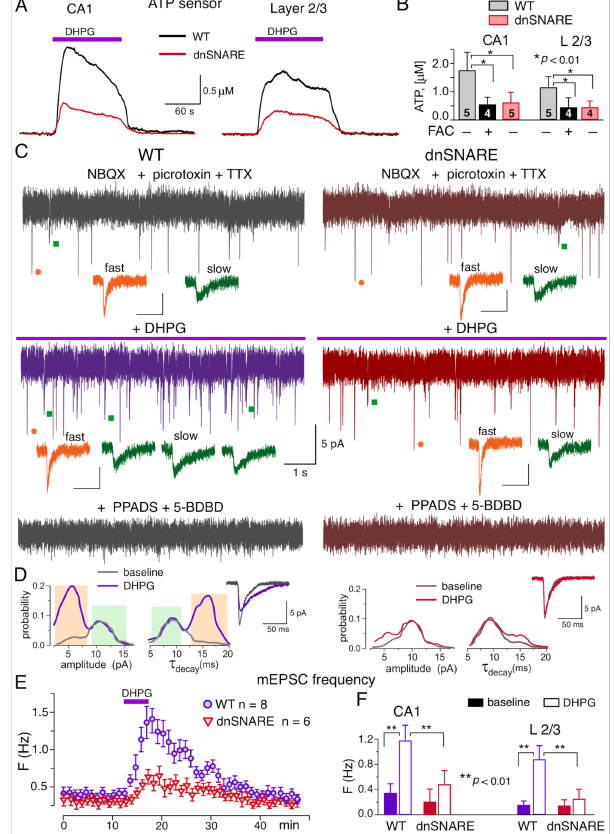
Figure 2. mGluR-activated release of ATP in hippocampal and neocortical slices. ( A , B ) Release of ATP assessed with microelectrode biosensors to ATP placed in the stratum radiatum of CA1 area and layer 3 of neocortex. ( A ) Representative ATP-responses to the application of DHPG. ( B ) The average peak amplitude of DHPG-elicited ATP-transients recorded in the CA1 and layer 2/3 of wild-type and dnSNARE mice (mean ± SD for number of slice indicated); asterisks (*) indicate the significance of difference according to t -test. Note the significant decrease in the DHPG-evoked responses in the dnSNARE mice and in the WT mice under FAC. ( C – F ) Spontaneous currents were recorded in the CA1 pyramidal neurons of WT (left) and dnSNARE (right) mice at − 80 mV under picrotoxin, NBQX and TTX. ( C ), the representative traces show, from top to bottom, the currents recorded in the baseline, 5 min after DHPG application, and in the presence of P2X receptor antagonists PPADS and 5-BDBD applied 30 min after DHPG. Note that purinergic antagonists fully eliminated the spontaneous currents. The inlays show the examples of purinergic events of fast (orange) and slow (green) kinetics recoded as indicated by the dots; the scale bar in inlays are 50 ms and 5 pA. ( D ) The amplitude and decay time ( τ decay ) distributions and average waveforms (mean of 20 consecutive events) of the purinergic currents recoded before (baseline) and within 5 to 10 min after application of DHPG. Note the increase in the proportion of spontaneous currents of smaller quantal amplitude (left peak) and slower decay (right peak in the τ decay histogram) in the WT mice after application of DHPG. ( E ), the time course of average frequency of spontaneous purinergic currents recorded in the CA1 neurons (integrated within 1 min window); data are presented as mean ± SD for number of neurons indicated. ( F ), the average frequency of smaller-and-slower purinergic currents (identified as shown in panels C , D ) in the CA1 neurons of WT and dnSNARE mice before (baseline) and after application of DHPG (in 2–10 min window); mean ± SD for the 8 WT and 6 dnSNARE neurons. Asterisks (**) indicate the significance of difference from the baseline and between the